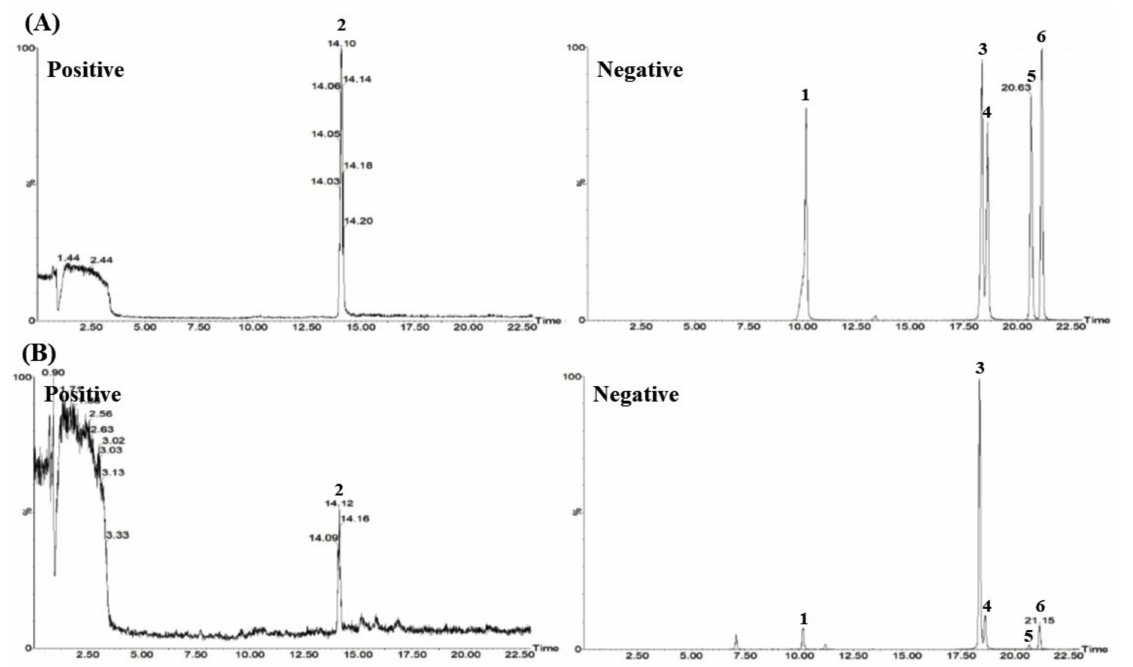
Figure 2. Total ion chromatograms of mixtures of the six marker components ( A ) and 80% ethanol extract of the P. pubescens leaves ( B ) were measured by LC–MS/MS MRM in positive and negative ion modes. Chlorogenic acid ( 1 ), p -coumaric acid ( 2 ), isoorientin ( 3 ), orientin ( 4 ), vitexin ( 5 ), and